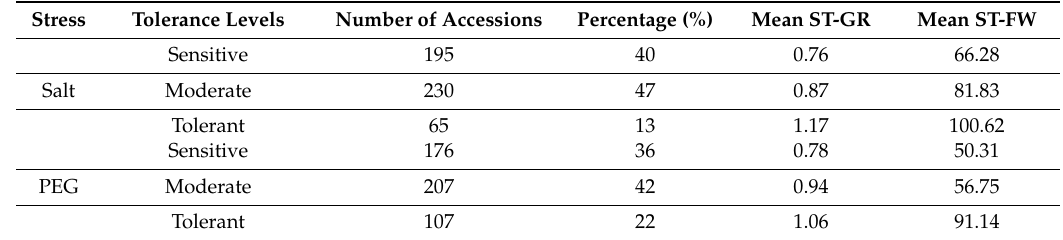
Table 2. Distribution of the accessions according to their tolerance levels to salt and drought